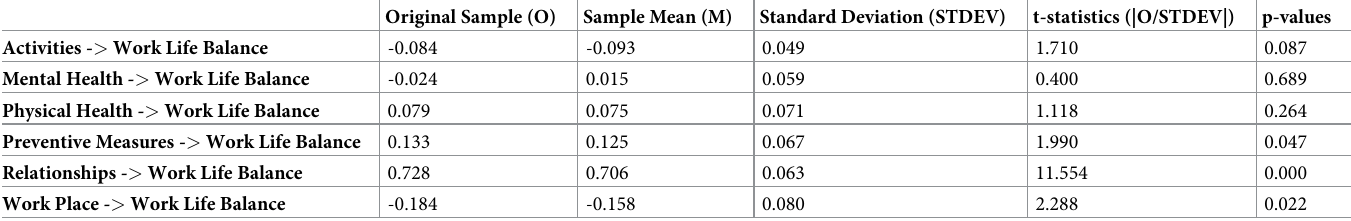
Table 9. Path coefficients, t-statistics, and p-values of the structural